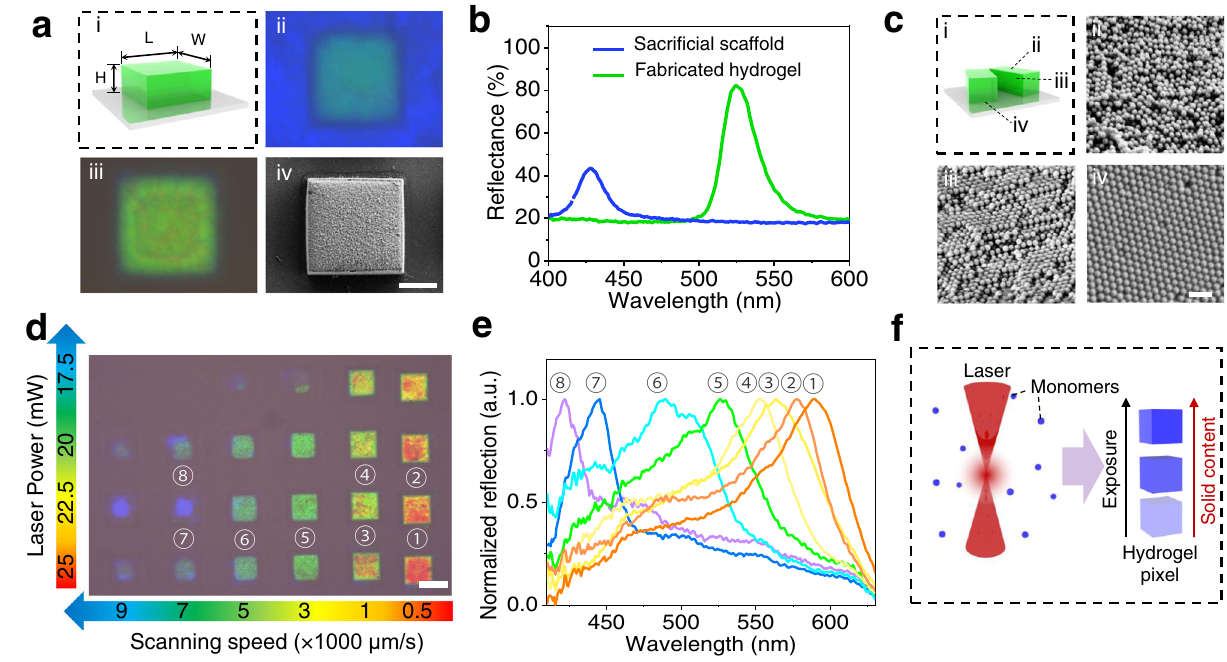
c SEM images of the hydrogel microcube from (ii) top, (iii) cross-section and (iv) bottom ( Φ =180nm, Scale bars: 500nm). d Microcube array fabricated with gradient-variedlaserpowerandscanningspeed,demonstratingthedependenceof the obtained structure color with the TPL processing parameters. Scale bars: 50 μ m. e Re fl ectionspectraoftheselectedmicrocubesin d . f Proposedmechanism of the exposure-dependence of the structure color of the fabricated hydrogel